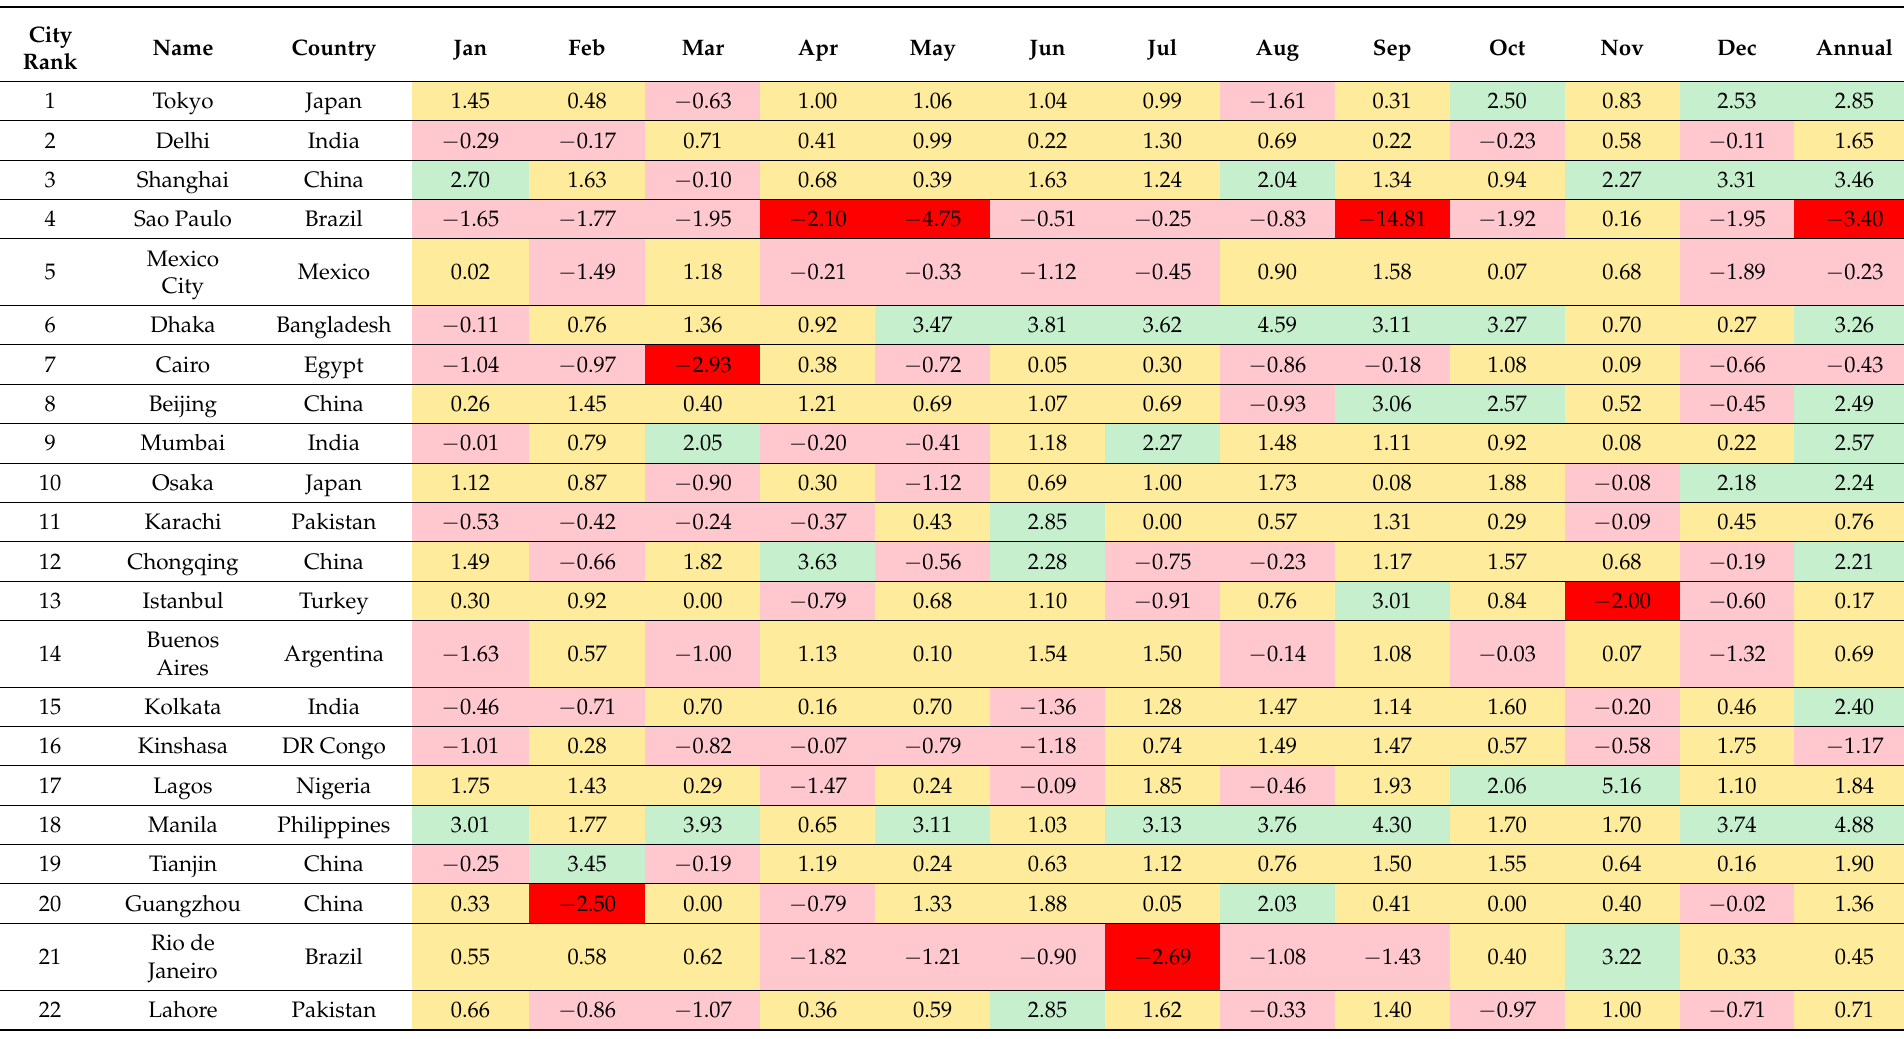
Table 2. Monthly and annual Z Statistics